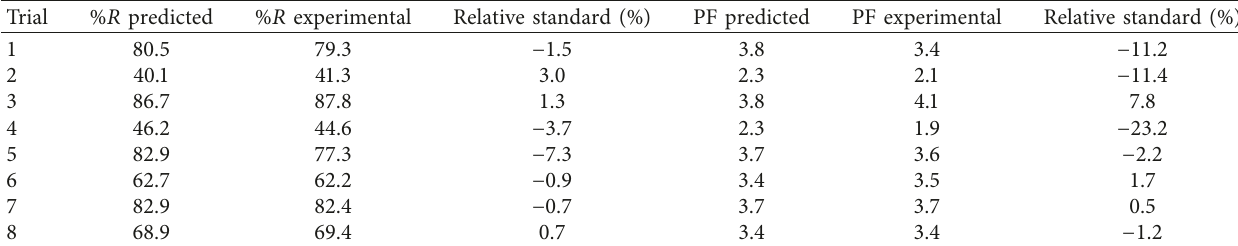
Table 2: Responses of 2 3 experimental design.